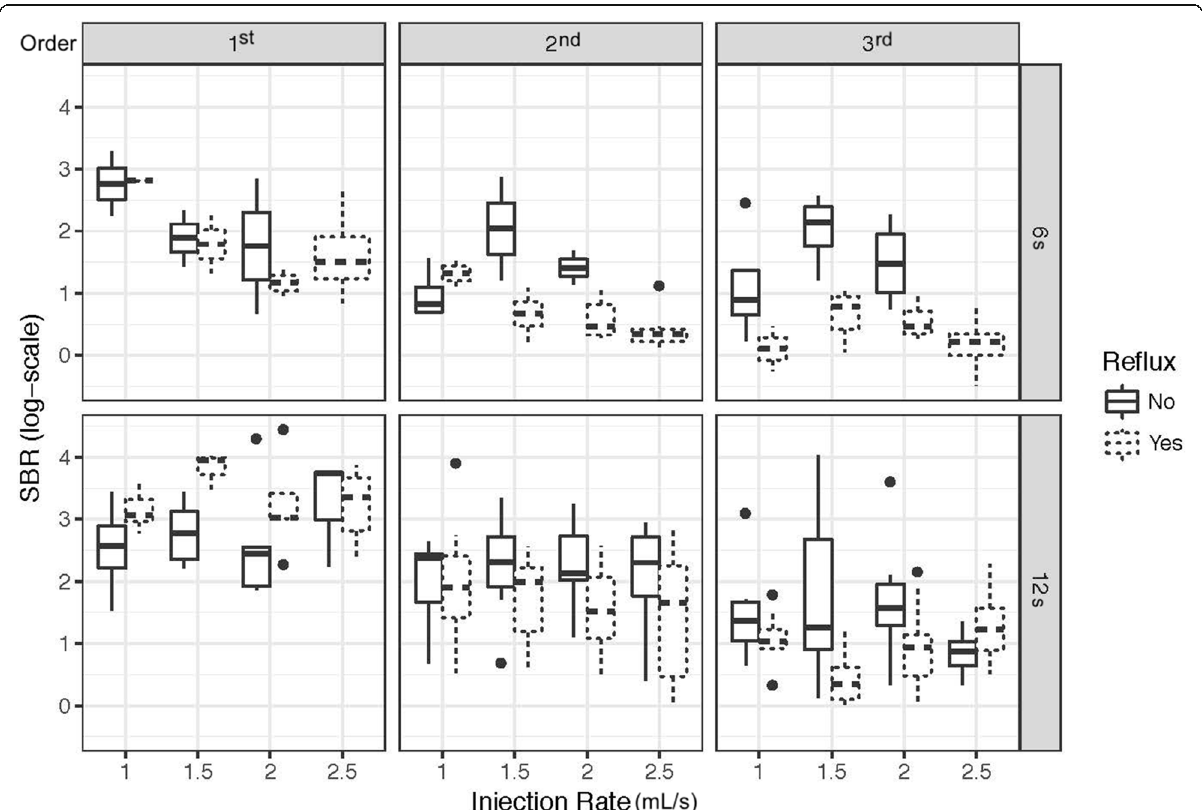
Fig. 6 Box-and-whisker plot showing the relationship between reflux, scan time, injection rate, and hepatic arterial branches on observed sideband ratio (SBR). Horizontal lines in the box represent median values. Although reflux was associated with slightly lower SBR values, this effect was not statistically